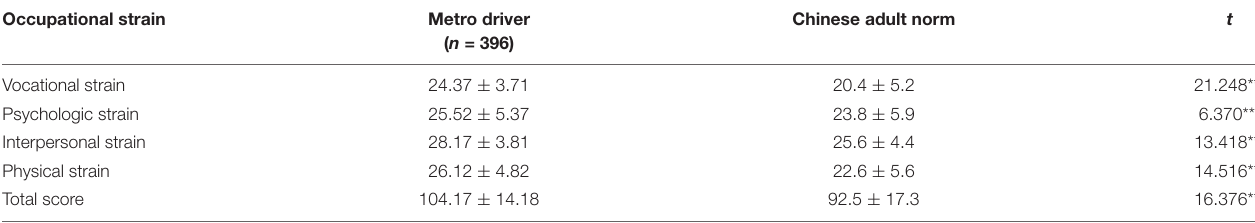
TABLE 8 | Occupational strain assessment results for metro drivers from PSQ.